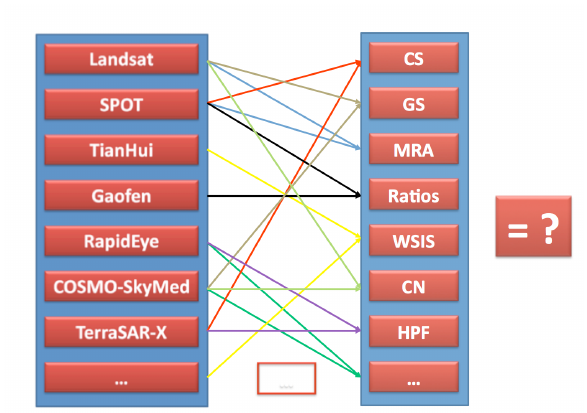
Figure 1. How to decide which fusion algorithm is yielding the best result for a certain data set?